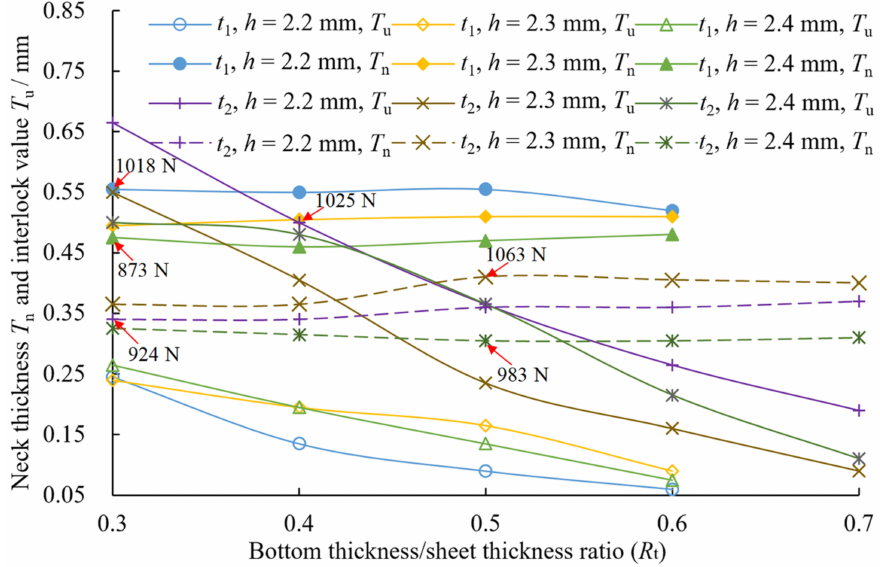
Figure 12. Variation of Interlock value and neck thickness of joints with R t